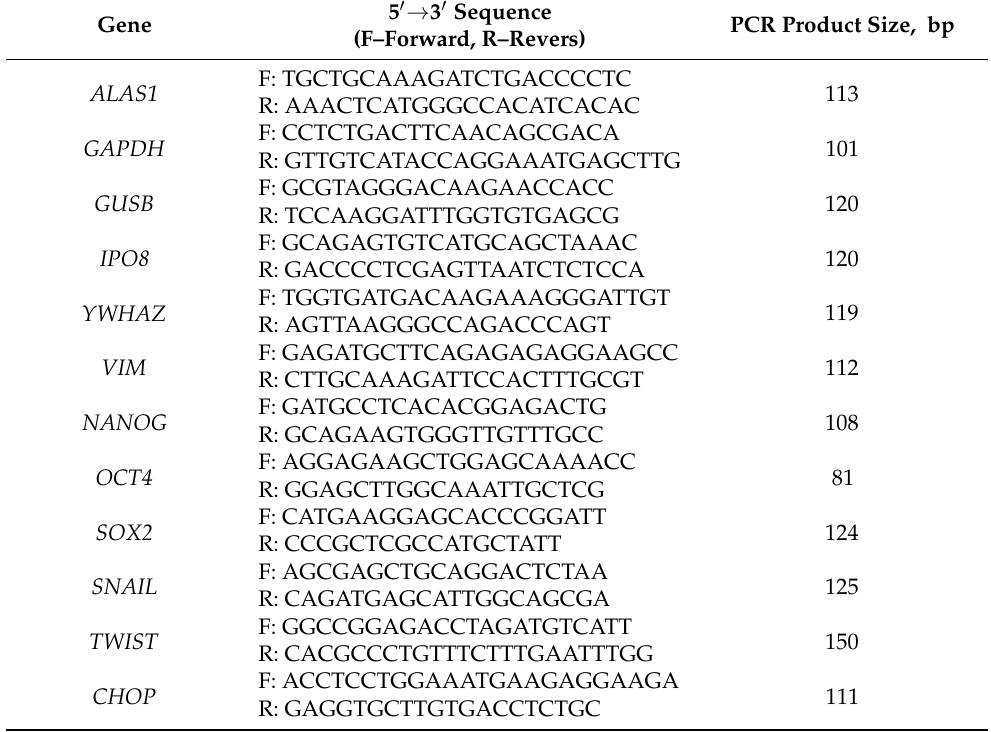
Table 4. Gene-specific primers used for real-time polymerase chain reaction (PCR).